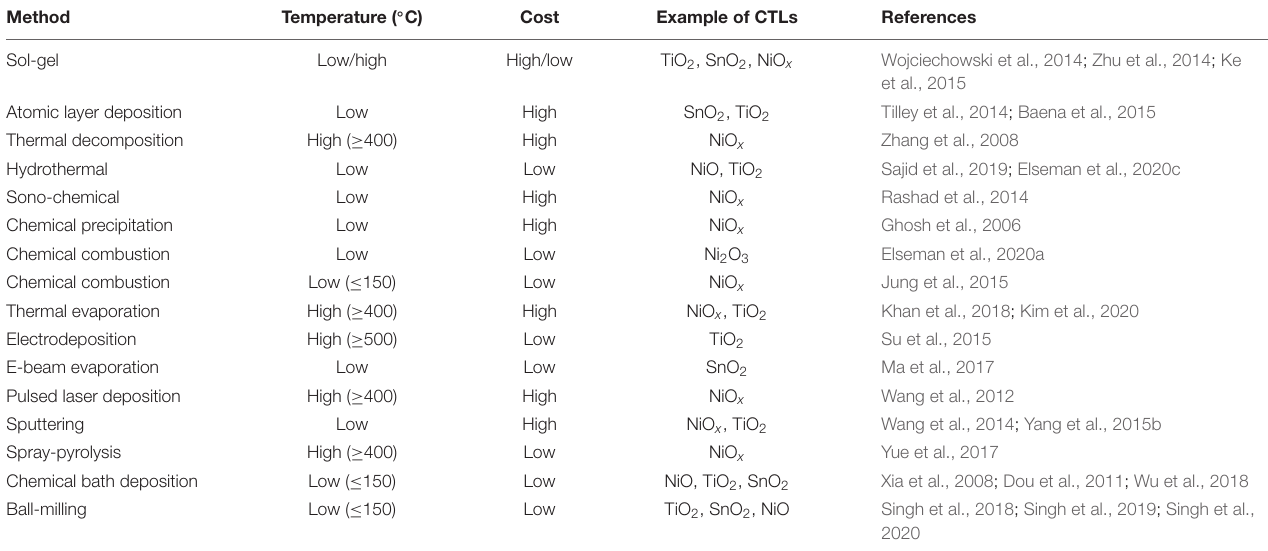
TABLE 1 | Classification of some common preparation methods for charge transport layers (CTLs) in terms of cost and processing